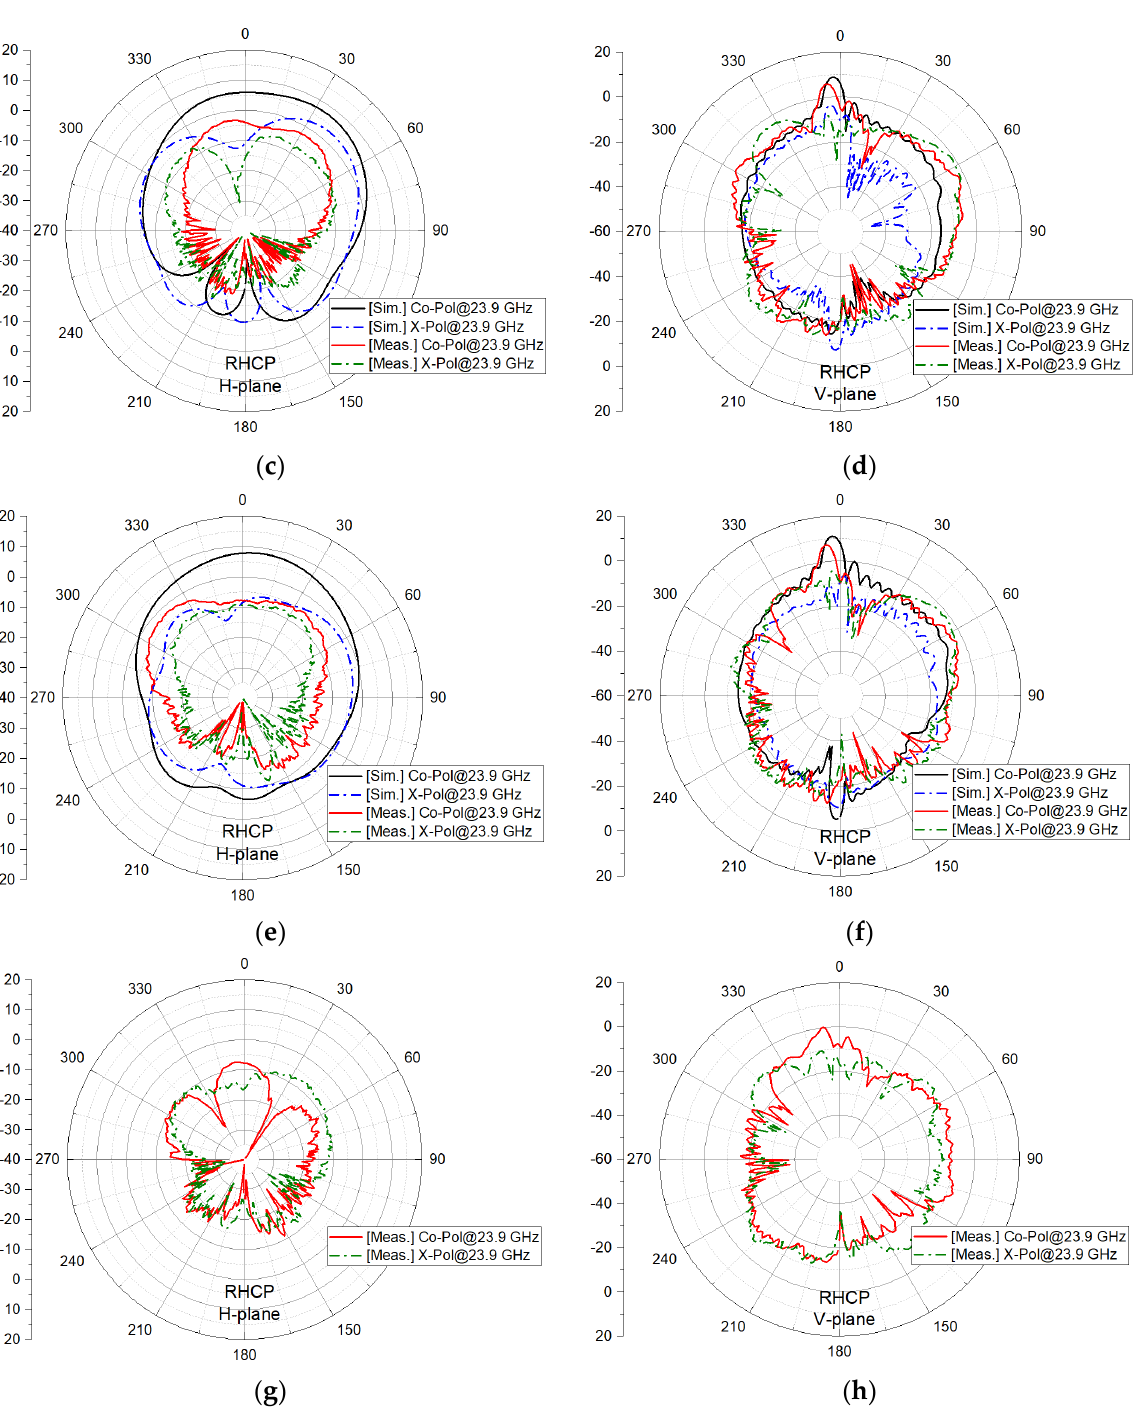
Figure 14. Simulated and measured radiation patterns: ( a ) horizontal and ( b ) vertical planes for mode 1, ( c ) horizontal and ( d ) vertical planes for mode 2, ( e ) horizontal and ( f ) vertical planes for mode 3, and ( g ) horizontal and ( h ) vertical planes for mode 4.